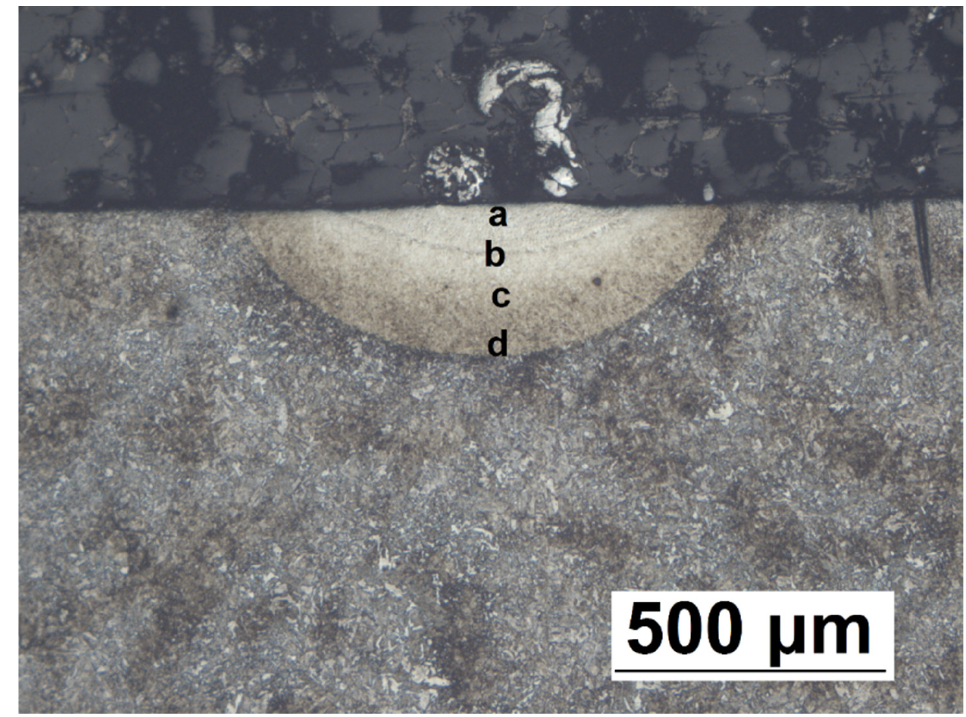
Figure 6. Optical micrograph of the cross-section of the laser-hardened region obtained using 46 J/mm 2 heat input at 10 mm defocus position. a , b , c and d represent laser melted zone (LMZ), transition line, laser transformation-hardened zone (LHZ) and heat affected zone (HAZ) respectively.